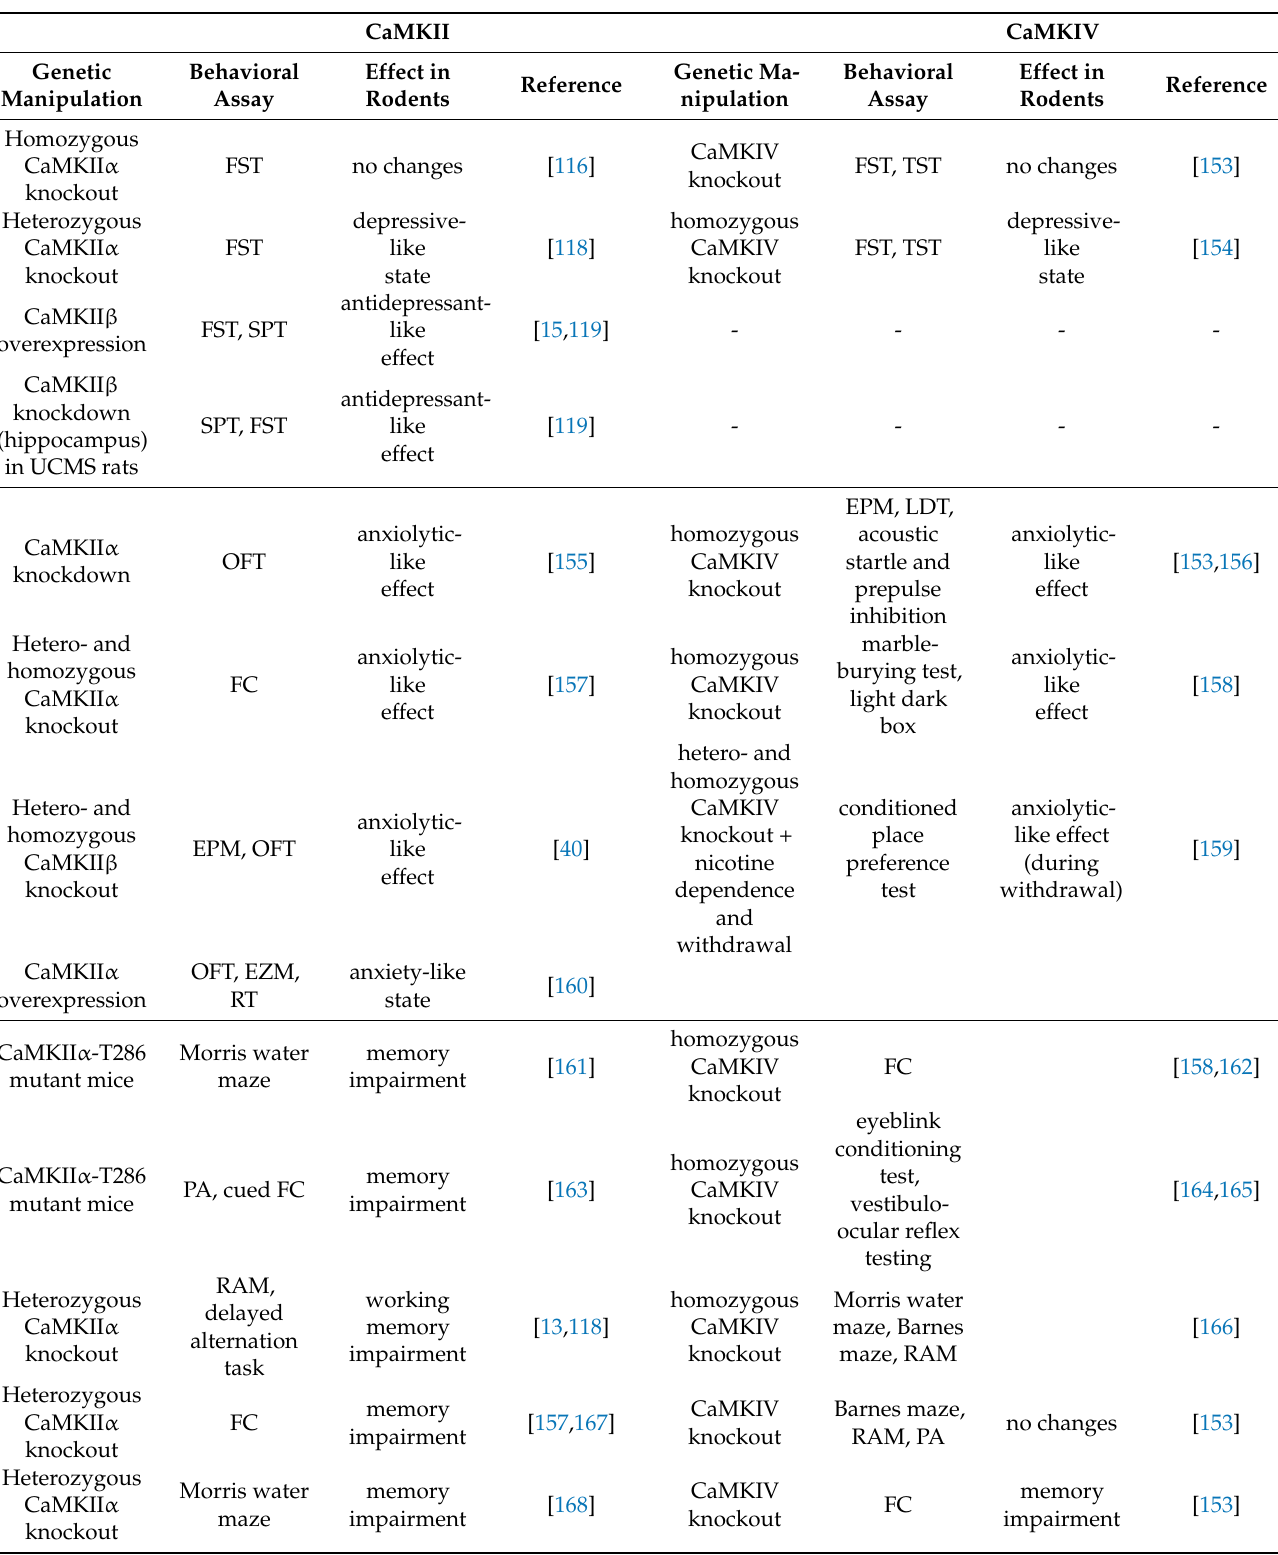
Table 2. Summary of the effects of calcium/calmodulin-dependent kinases II and IV genetic manipulation in rodents. CaMKII CaMKIV Genetic Ma- Behavioral Effect in Genetic Effect in Reference nipulation Assay Rodents Assay Rodents